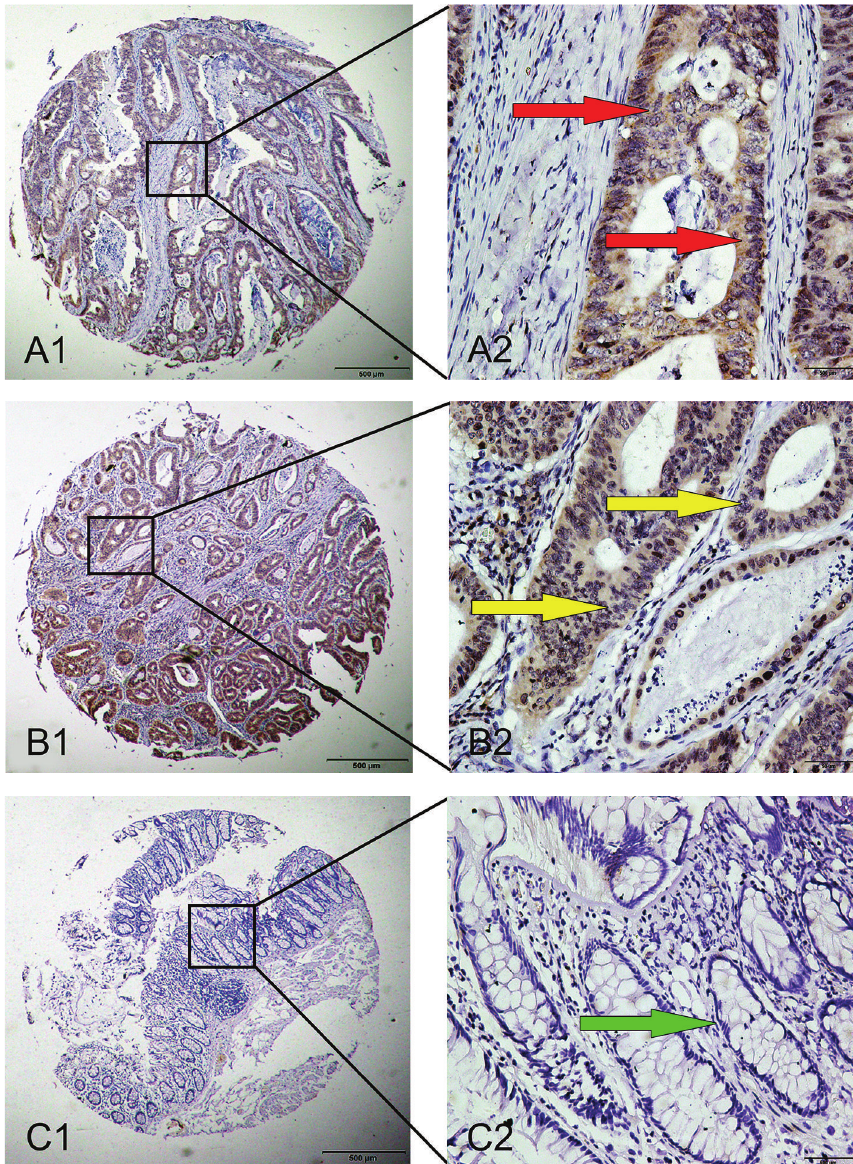
Figure 2: Representative images of Rab27b protein expression in colorectal cancer (CRC) tissues and corresponding noncancerous tissues with tissue microarray (TMA). A1 and A2: positive immunohistochemical (IHC) staining of Rab27b protein in CRC sample. Red arrows show positive staining in the cytoplasm of cancer cells. B1 and B2: positive IHC staining of Rab27b protein in CRC sample. Yellow arrows show positive staining in the nuclei of cancer cells. C1 and C2: negative IHC staining of Rab27b protein in matched noncancerous tissue sample. Green arrow shows negative staining in noncancerous cell (epithelial cell). Original magnification × 40 in A1, B1, and C1; × 400 in A2, B2, and